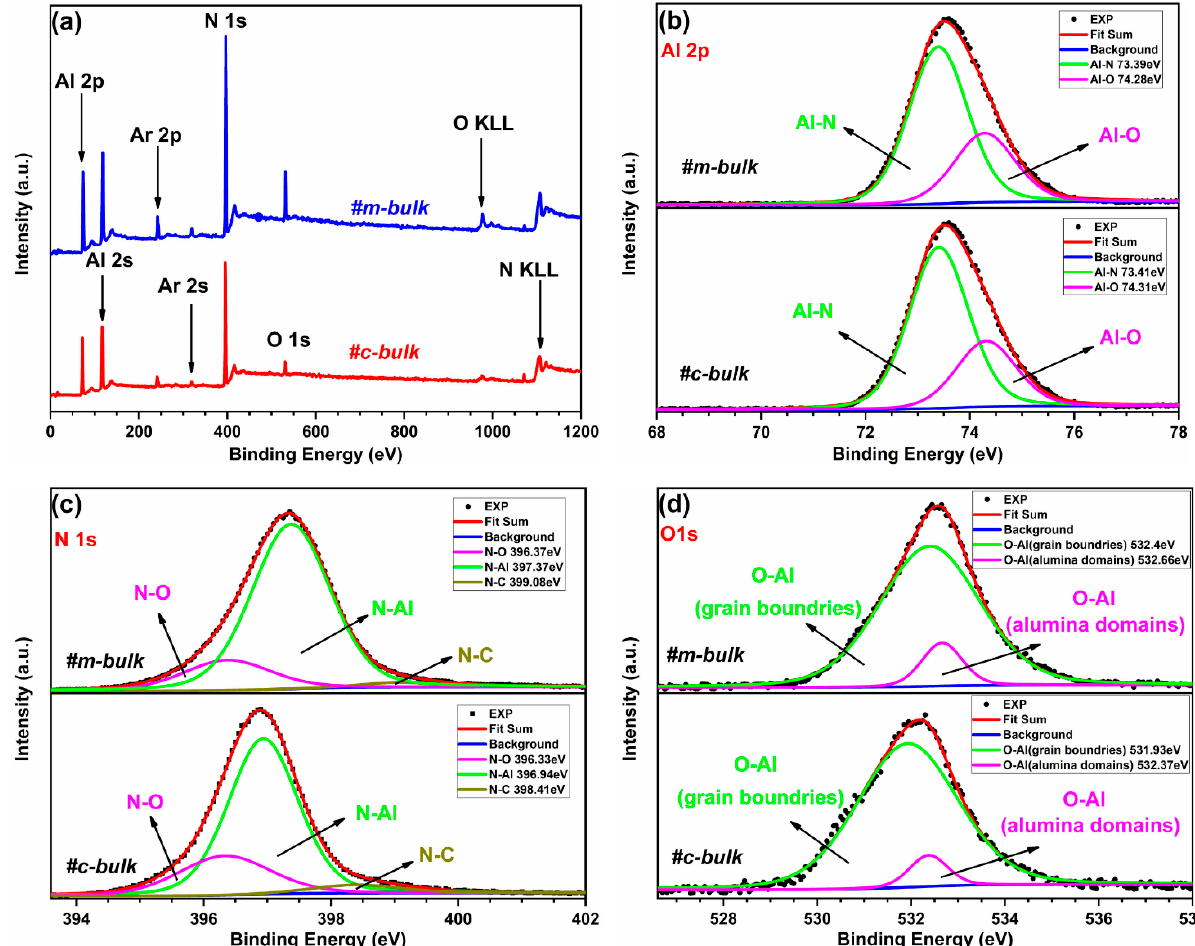
Figure 2. XPS survey spectra ( a ) and fine-scan spectra of ( b ) Al 2p, ( c ) N 1s, and ( d ) O 1s for m-bulk and c-bulk AlN crystals.